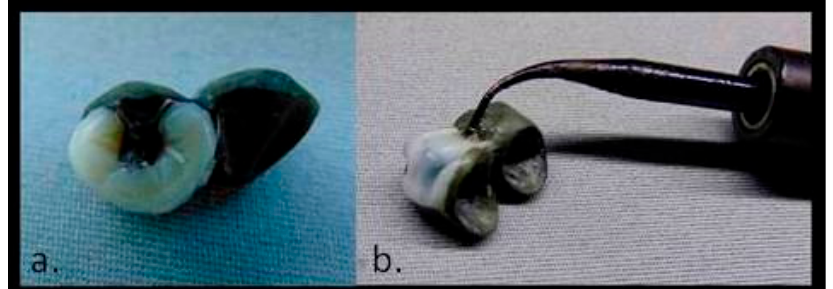
Figure 9. ( a ). Direct wax-based construction, without detachment of the framework (Mb +); ( b ). construction method of waxing up.